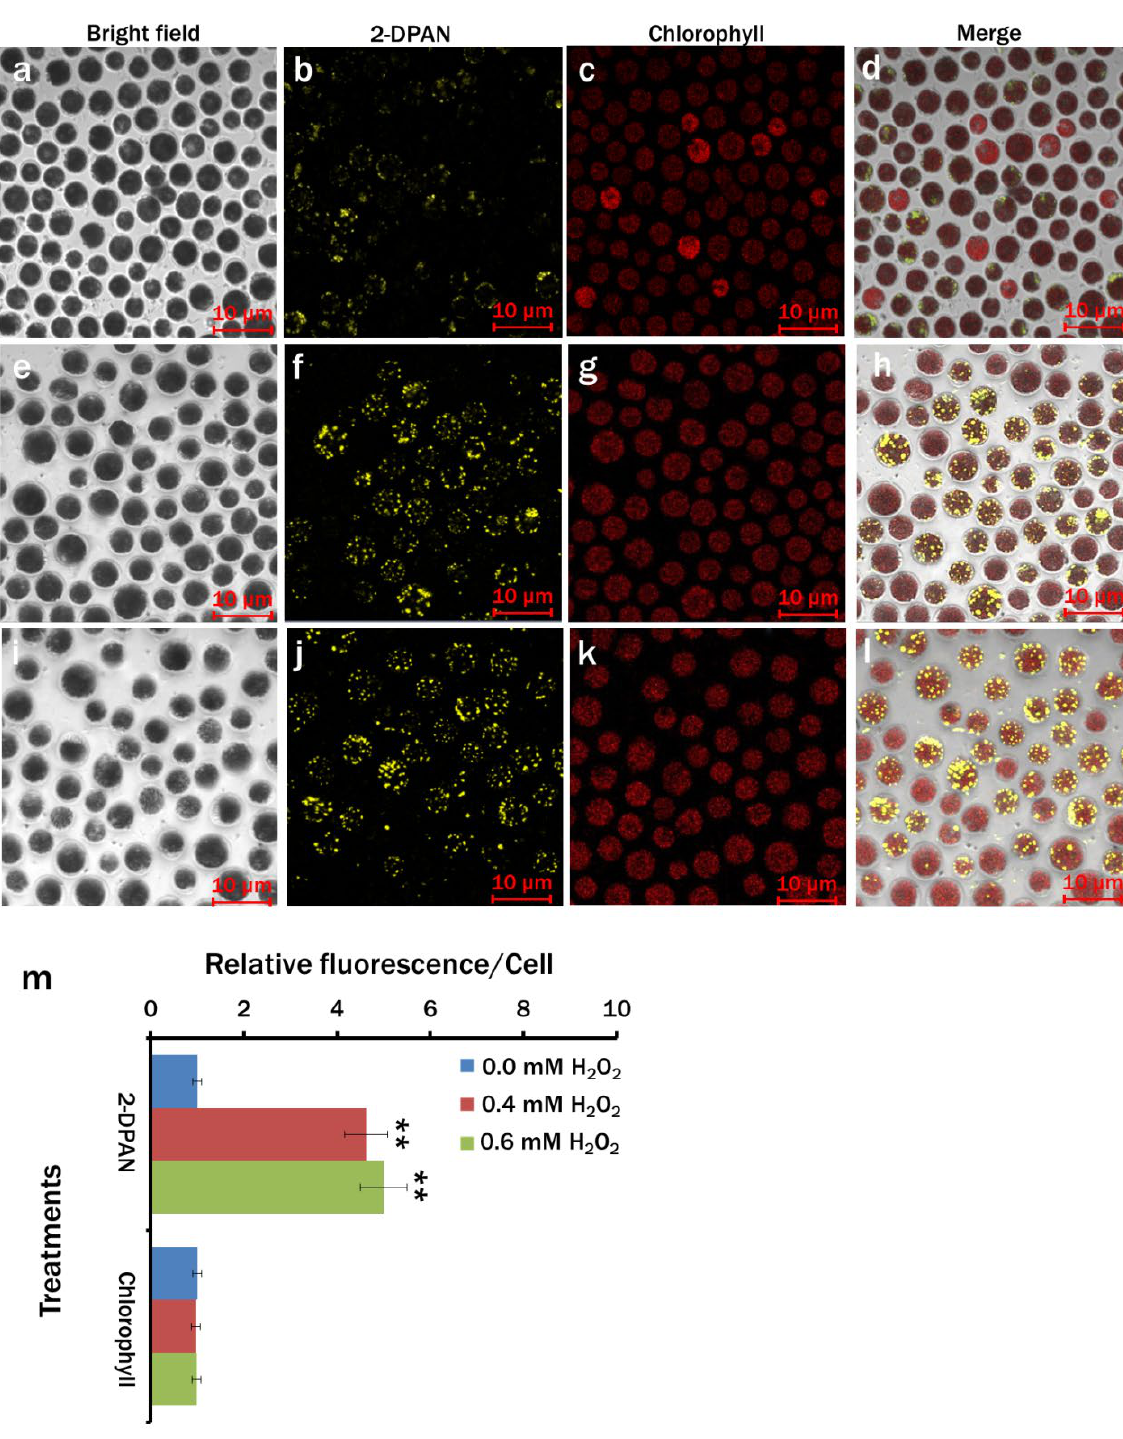
Figure 8. Imaging of lipid drops in H 2 O 2 treated Chlamydomonas reinhardtii . Lipids were labelled with lipid-specific AIE nanoprobe, 2-DPAN(20 µM; incubation-30 min). Cells were cultured in 0.0 mM ( a – d ), 0.4 mM ( e – h ) and 0.6 mM ( i – l ) H 2 O 2 supplemented MBL medium. Bright-field images: ( a , e , i ); Fluorescence images—2-DPAN: ( b , f , j ) (λ ex : 488 nm, λ em : 570-650 nm) and Chlorophyll: ( c , g , k ) (λ ex : 488 nm, λ em : 685–758 nm); Merged images: ( d , h , l ). ( m ) Relative fluorescence intensity/cell for different treatments. Values are relative to the control condition (0.0 mM H 2 O 2 ). Averages shown as mean ± SE; ** p < 0.01; Images were taken with Zeiss LSM 880 Airyscan confocal microscope.